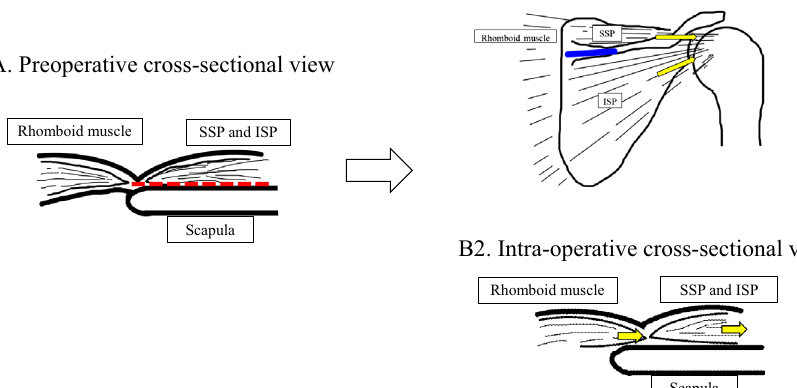
Figure 2. Schema of modi fi ed Debyere-Patte (DP) technique. (A) Preoperative cross-sectional view. (B1) Intra-operative posterior view of the right shoulder; (B2) Intra-operative cross-sectional view. Red dotted line: SSP and ISP, while maintaining continuity with the rhomboid fascia, were detached from the medial edge of scapular and advanced laterally. Blue line: skin incision. Yellow arrow: pulling direction of torn tendons with the rhomboids. Abbreviations: SSP: supraspinatus muscle, ISP: infraspinatus muscle. (Modi fi ed illustration of Morihara et al.